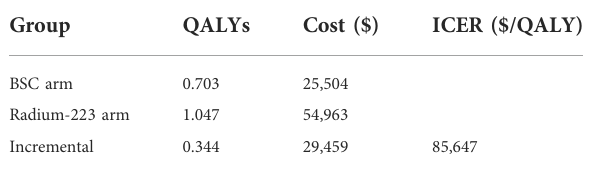
TABLE 3 Base-case model